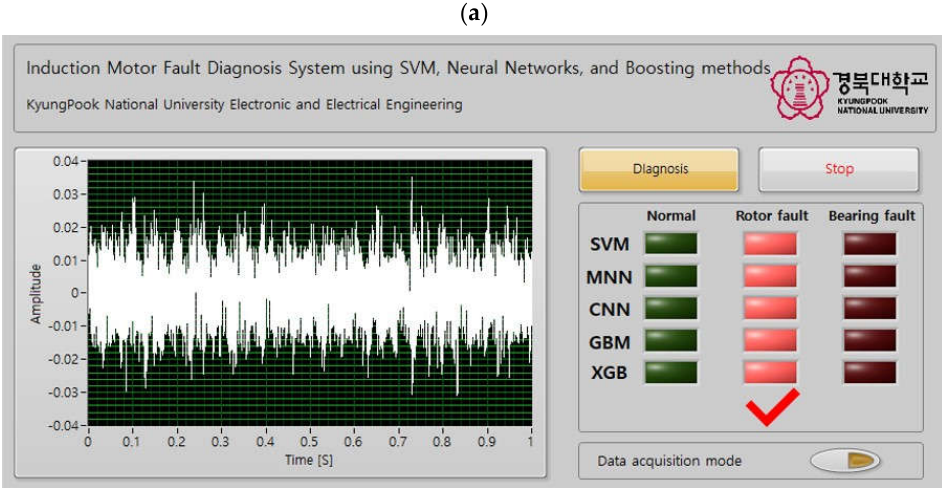
( c ) Figure 13. Fault diagnosis and results of induction motor using graphical user interface. ( a ) Re- sults of normal state induction motor fault diagnosis using graphical user inter-face. ( b ) Results of